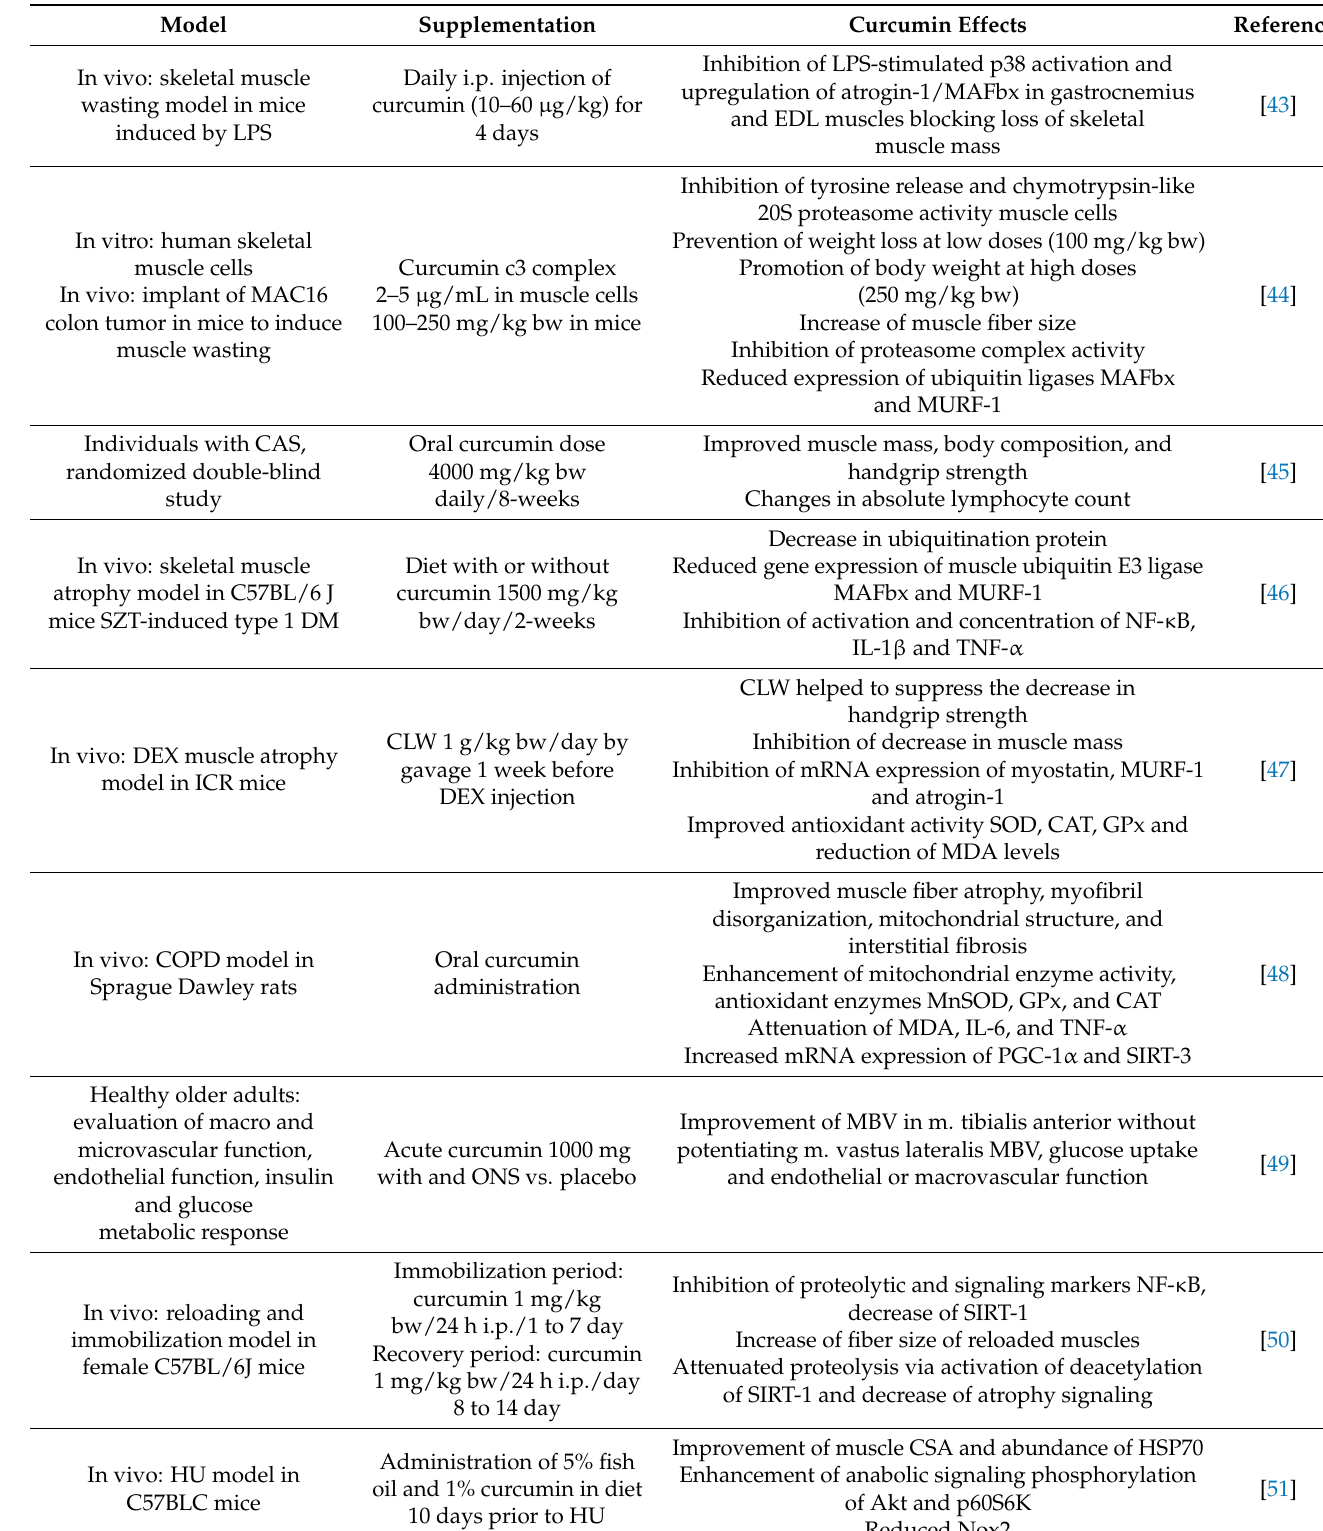
Table 1. Studies evaluating the effect of curcumin in several models of muscle